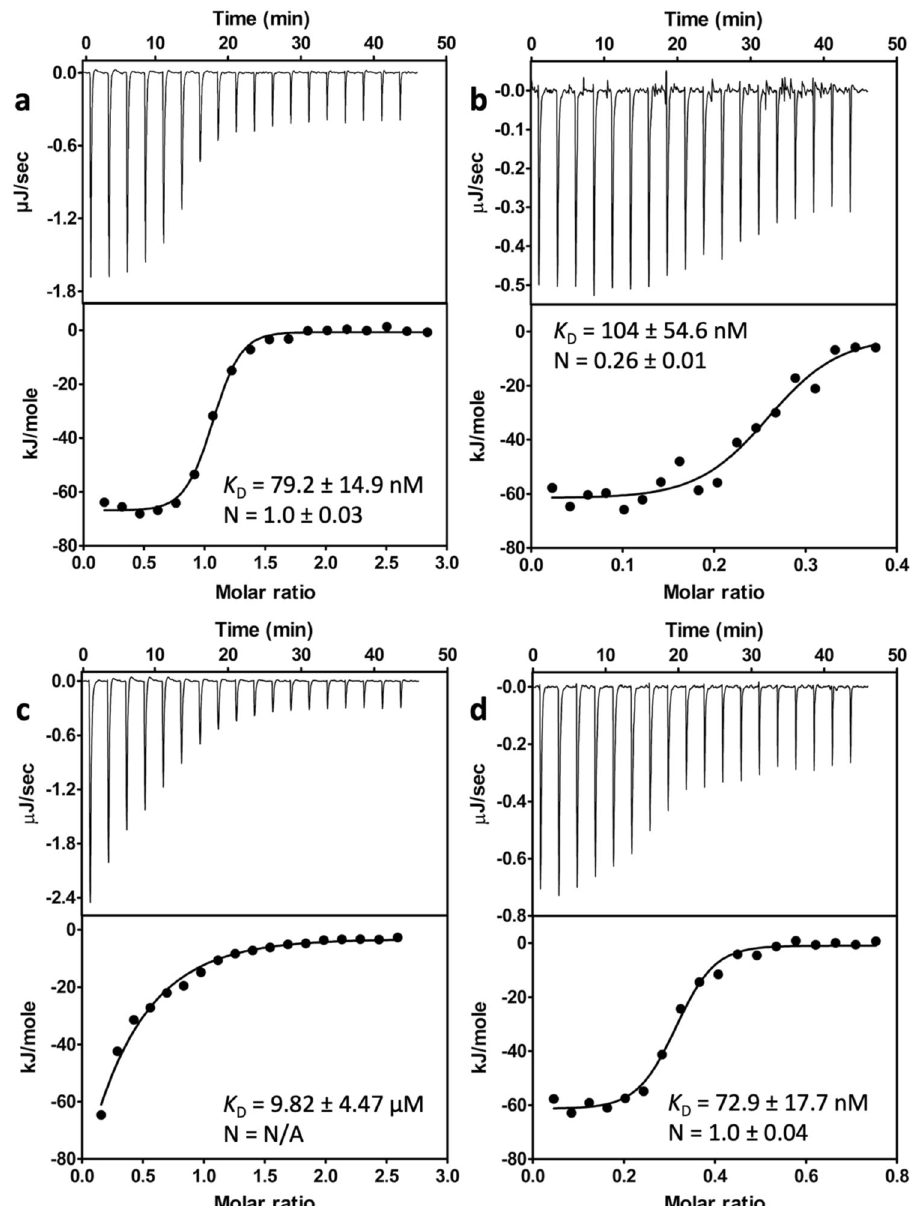
Fig. 7 Representative ITC fi tting results of RlpA-SPOR with binding partners. The ITC fi tting results of RlpA-SPOR with a SltB3, b PBP1a, c SltB1, and d PilA. The thermodynamic data were collected from the titration of RlpA-SPOR into the cell with a respective binding partner for b – d . Data were collected from the titration of SltB3 into RlpA-SPOR. All parameters were calculated by fi tting into a one-set-of-sites model. Buffer utilized for ITC was 50 mM Tris and 300 mM NaCl, pH 8.0. Data were presented as means ± SD from triplicate experiments. RlpA-SPOR construct was used for this these experiments. View Supplementary Data for source